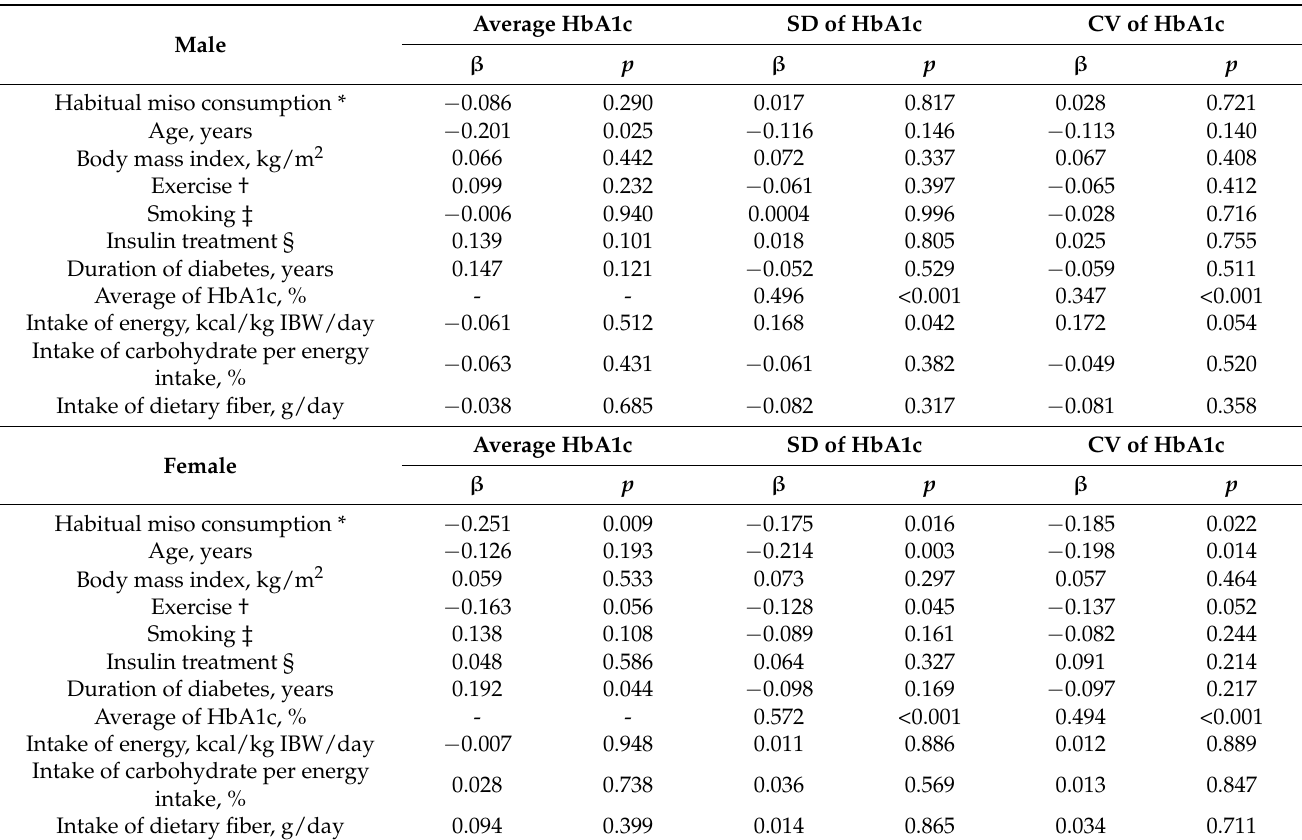
Table 5. Multiple regression analysis on average HbA1c, SD of HbA1c and CV of